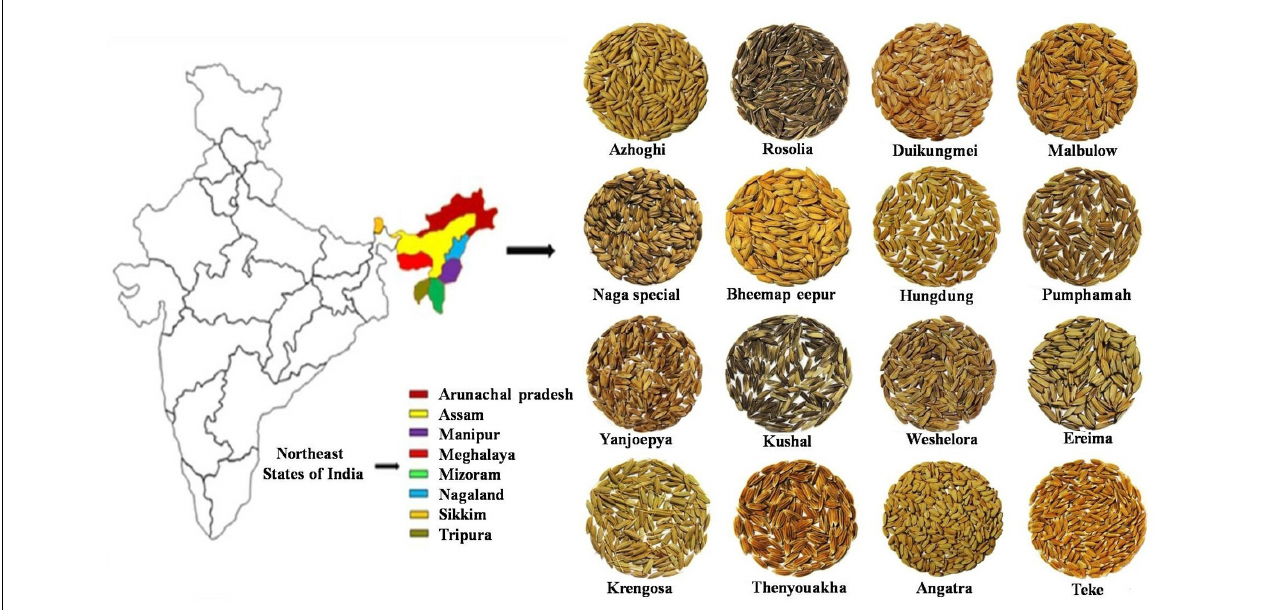
FIGURE 1 | Geographical distribution of diverse rice landraces (232) across North Eastern states of